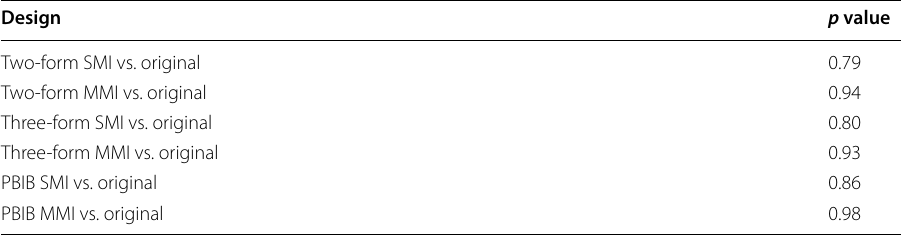
Table 6 Kolmogorov–Smirnov